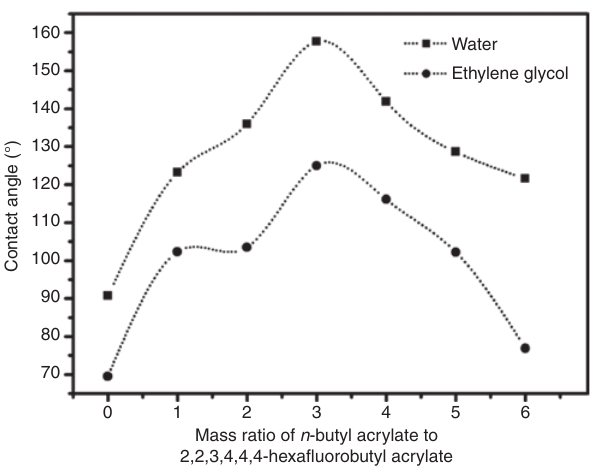
Figure 4: Effect of monomer ratio on the hydrophobicity of the samples.